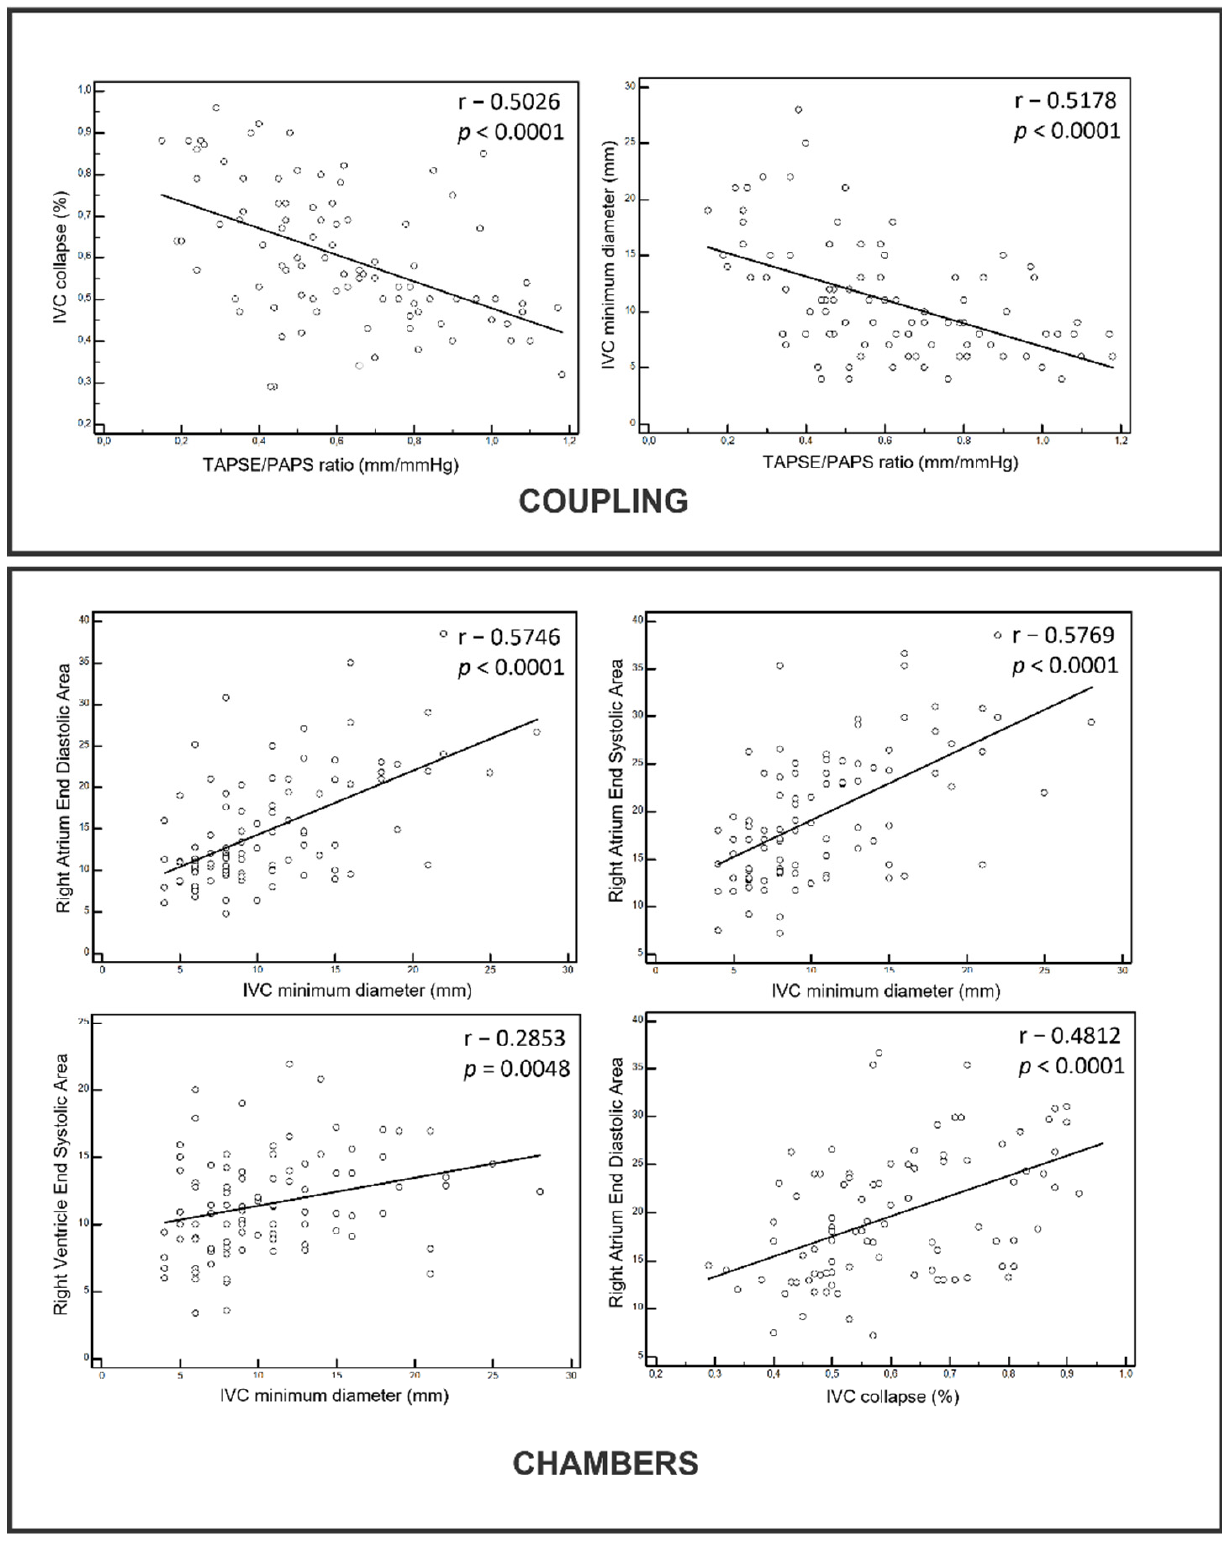
Figure 2. Correlations between US signs of ventricular/arterial coupling and right chambers volumes vs. congestion. IVC: Inferior Vena